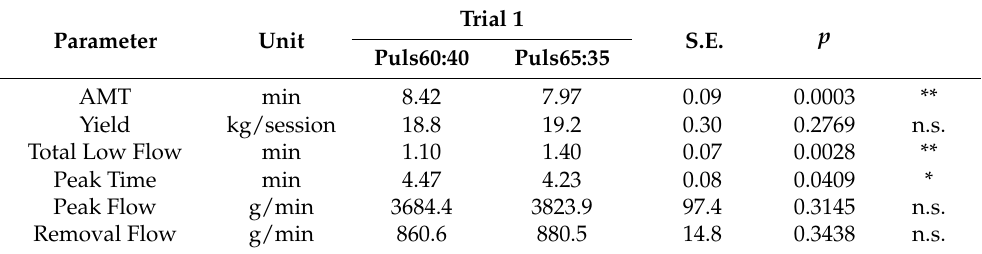
Table 1. Corrected least-square means (LSMeans), standard errors (S.E.s), and related statistical differences of Trial 1, where 2 pulsation ratios were tested. The control had the pulsation ratio set to 60:40, and the experiment had the pulsation ratio set to 65:35.